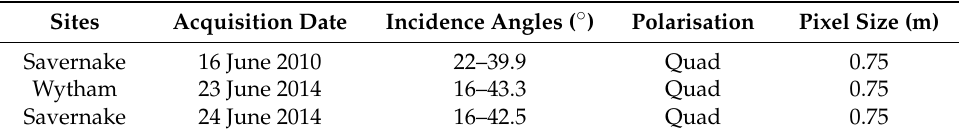
Table 1. Summary of available S-band AirSAR images used in this